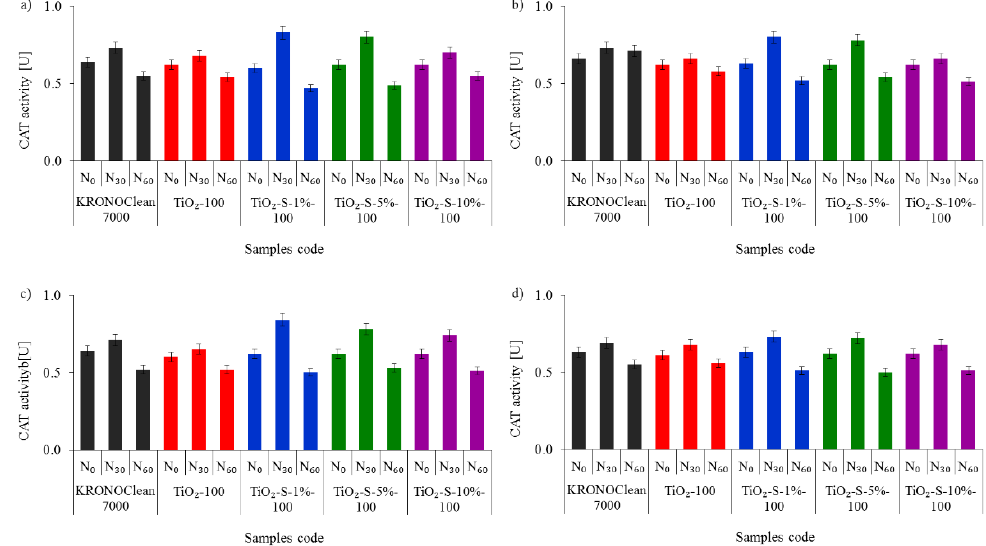
Figure 11. Influence of tested photocatalysts on the activity of bacterial catalase (CAT): ( a ) E. coli under UV-A; ( b ) E. coli under ASL; ( c ) S. epidermidis under UV-A; ( d ) S. epidermidis under ASL.